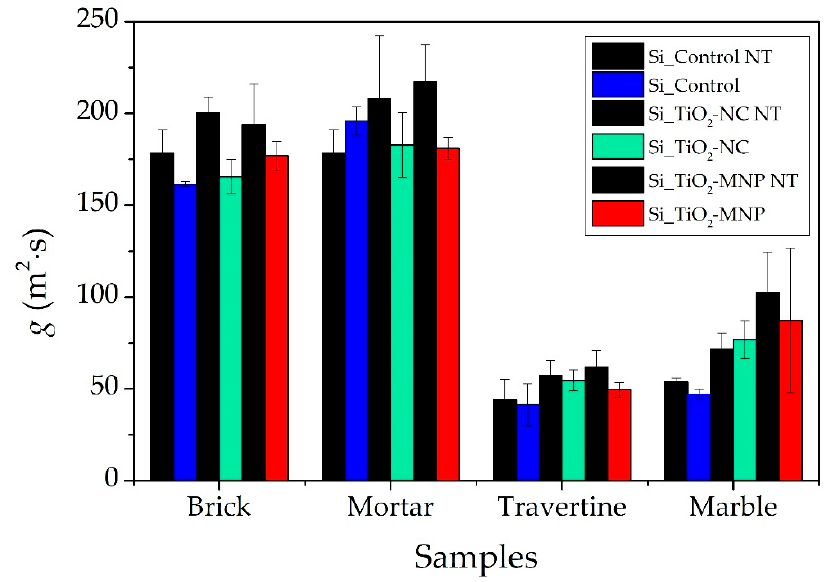
Figure 2. Water vapor permeability results expressed as water vapor permeability coefficient (g), shown for the individual specimens before (black bar on the left) and after (colored bar on the right) treatment. In detail, all untreated samples (NT) are in black; Si_Control: coating without